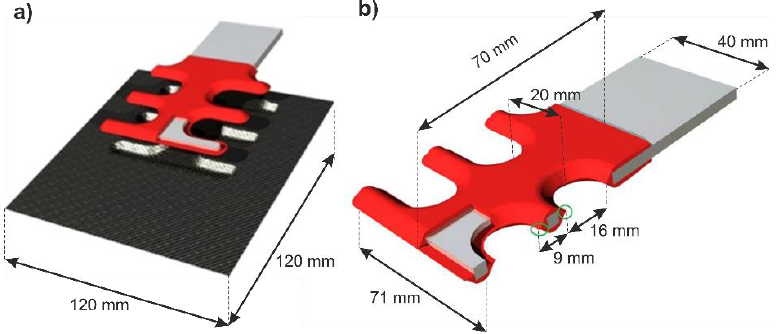
Figure 1. ( a ) Insert positioned between the CFRP-laminate, ( b ) geometric shape of the Al-Thermoplastic insert [25].